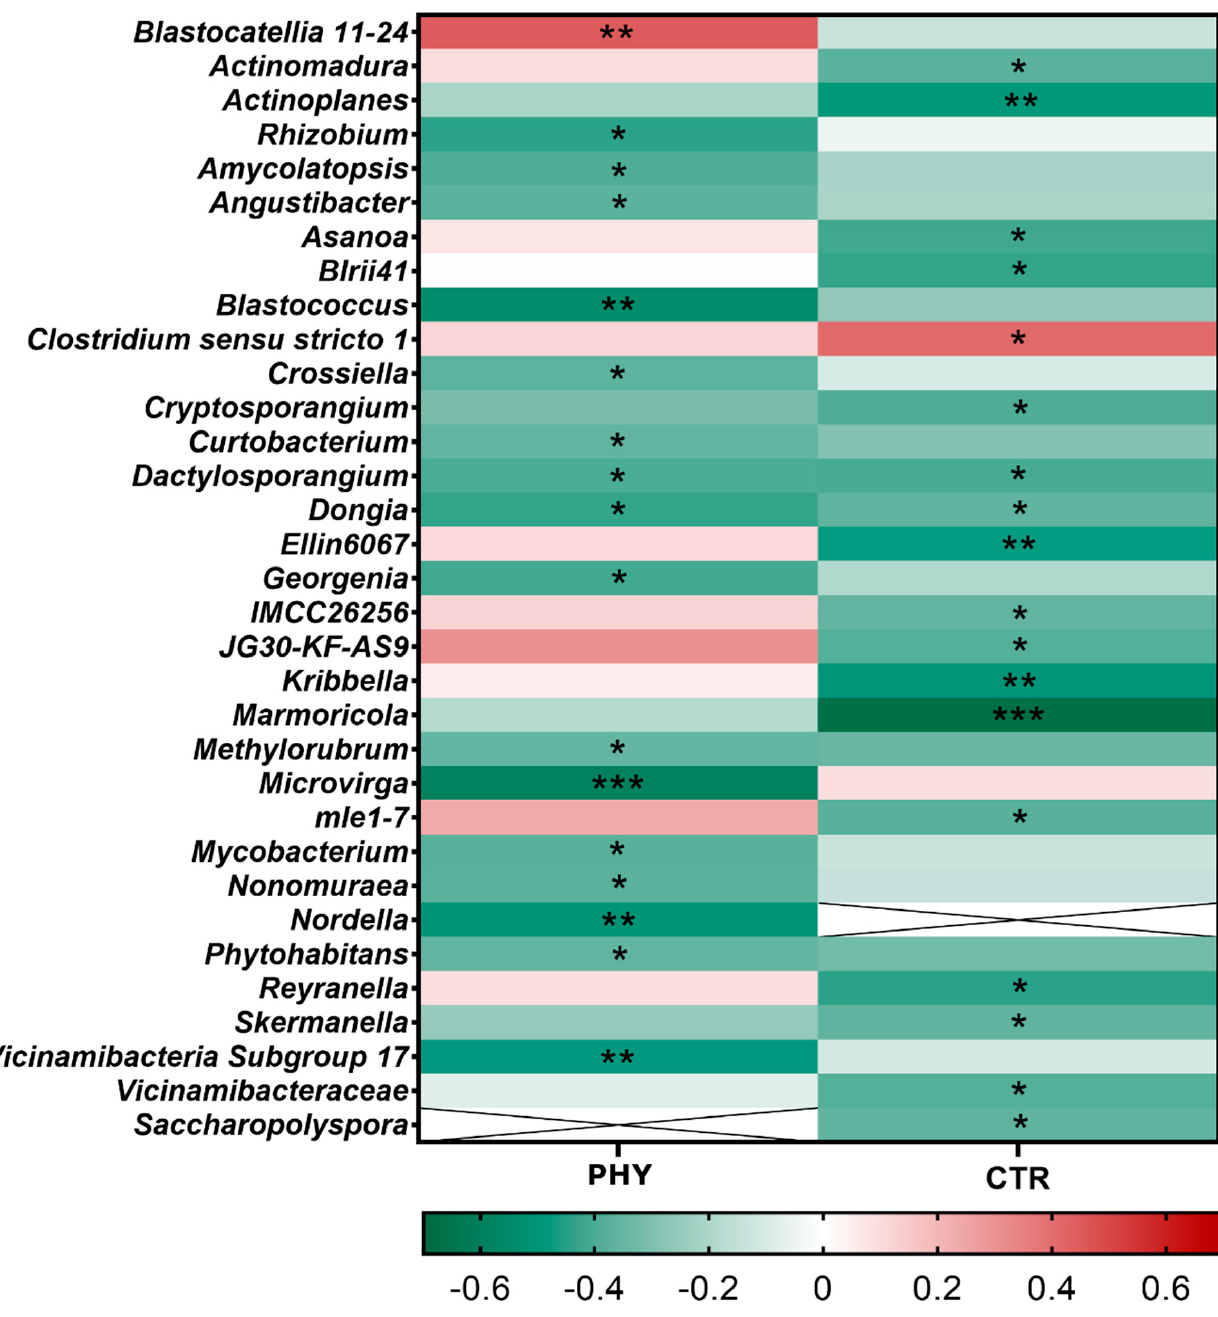
Figure 4. The temporal correlation heatmap. White cells with the x mark represent the genus not detected in that group. Green cell colour indicates negative temporal correlation and red cell colour indicates positive temporal correlation in each group, as shown in the heatmap correlation bar. * = p < 0.05; ** = p < 0.01; *** = p < 0.001